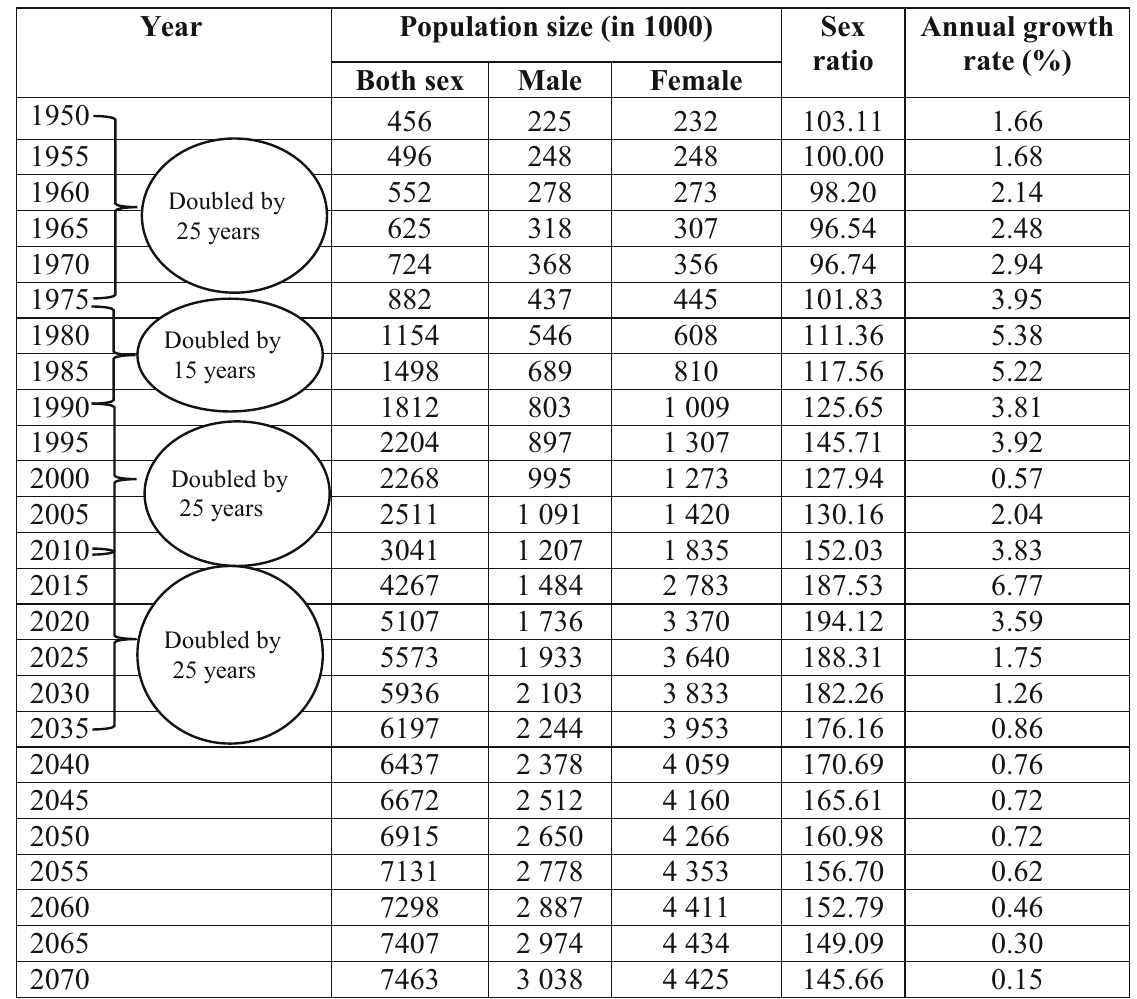
Table 1 Estimates and projections (medium variant) of total, male and female population size (in 1000), sex ratio, and annual growth rate of population: Oman 1950 –